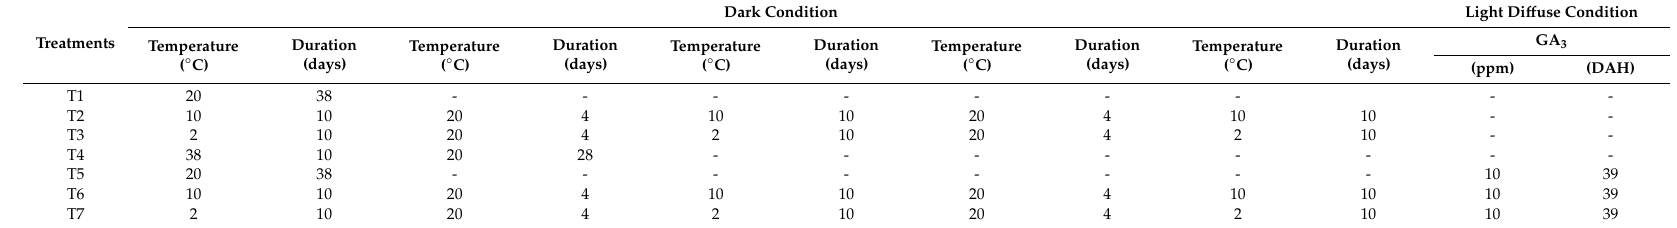
Table 1. Experiment 1 carried out at seed-tubers level in a storage chamber (1999). GA 3 : gibberellic acid application (aqueous solution of 10 ppm); DAH: days after harvesting.